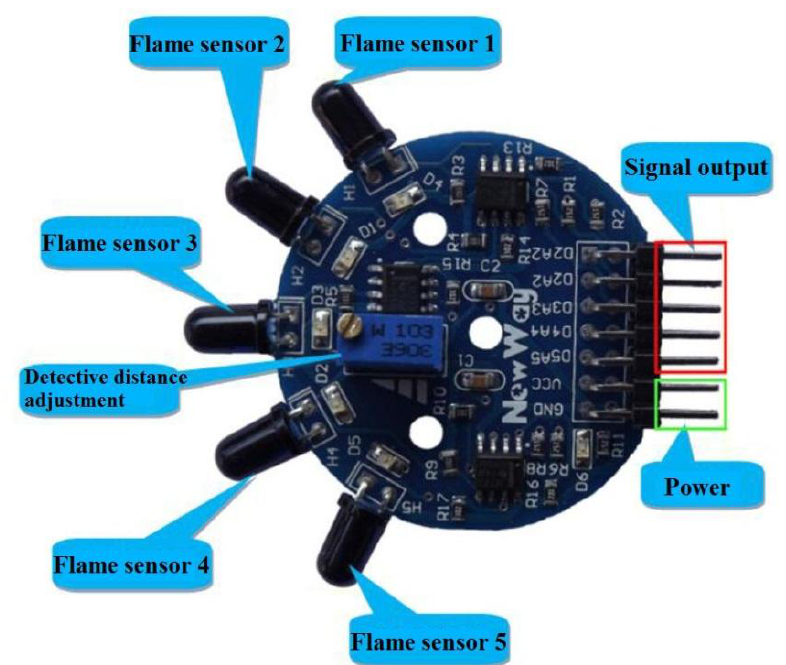
Figure 19. Five directions flame